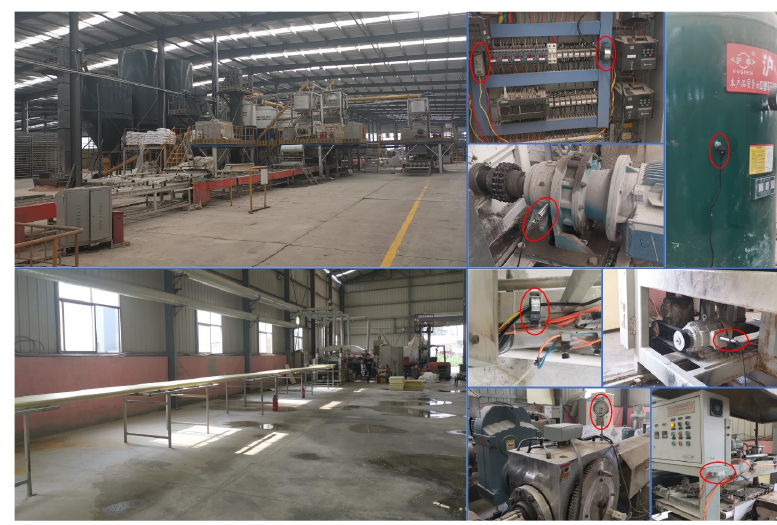
Figure 7. Pictures of production line equipment and sensors. Table 4. The IPC configuration for Res-LSTM model inference.